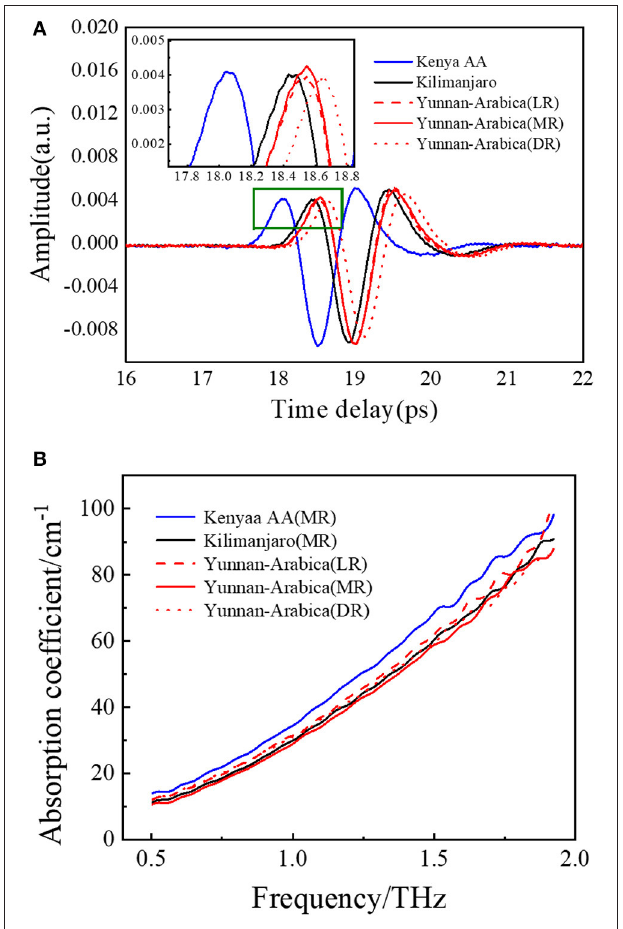
FIGURE 3 | Terahertz (THz) time-domain waveforms (A) and THz absorption coefficient spectra (B) .